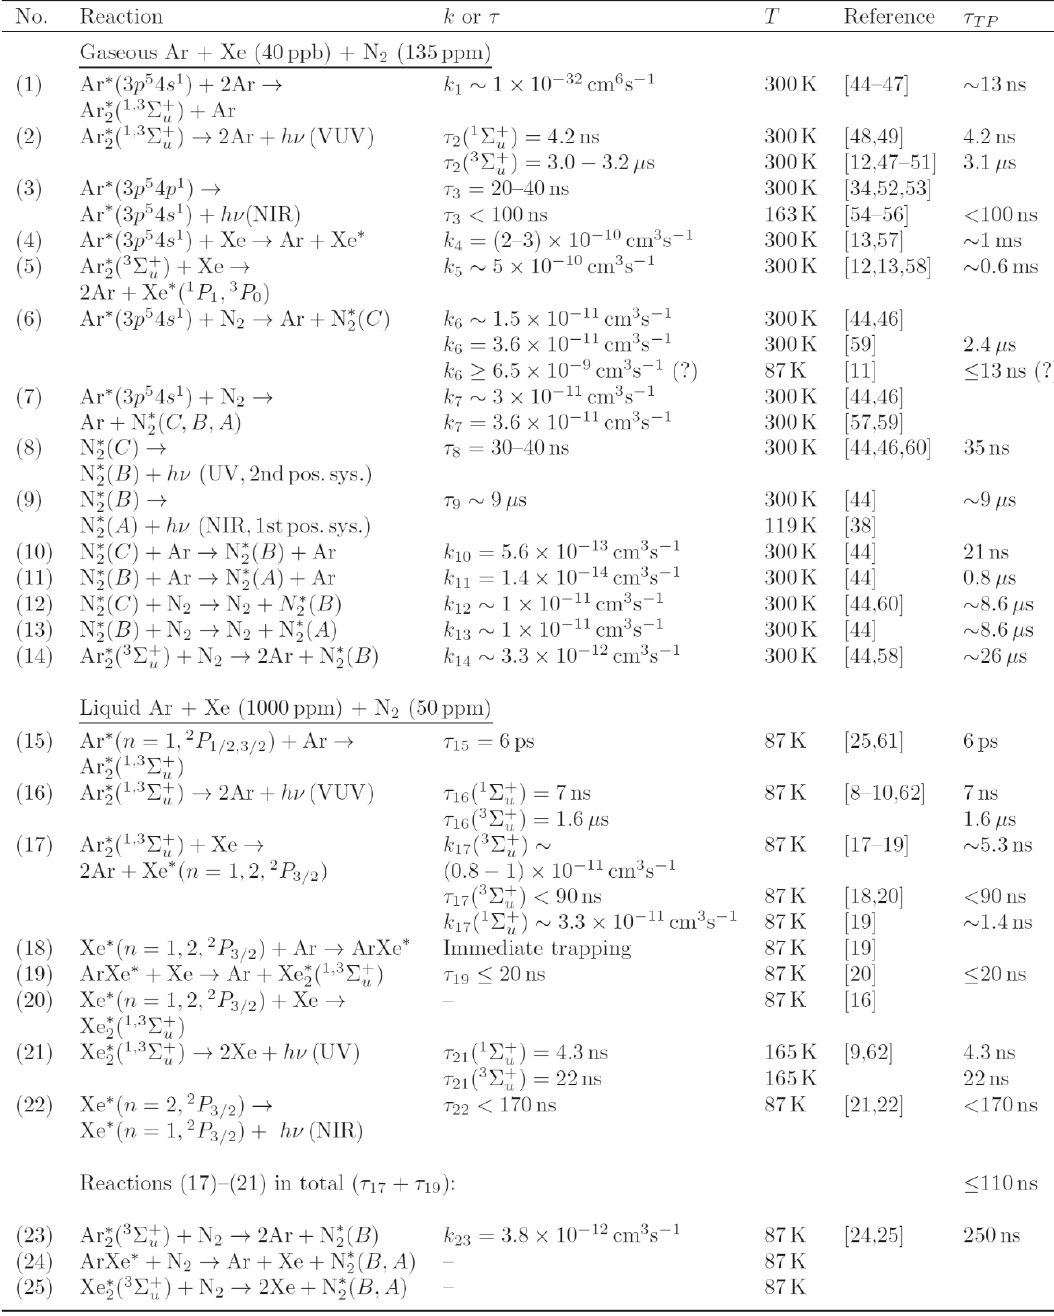
Table 1. Basic reactions of excited species relevant to the performance in the two-phase mode, namely in Ar in the gas and liquid phase, doped with Xe (1000 ppm in the liquid and 40 ppb in the gas phase) and N 2 (50 ppm in the liquid and 135 ppm in the gas phase), their rate (k) or time ( τ ) constants reported in the literature and their time constants reduced to given atomic densities at 87 K ( τ TP ), in particular for Ar to that of 8.63 × 10 19 cm − 3 and 2.11 × 10 22 cm − 3 in the gas and liquid phase, respectively [7]. The references presented in the table are those of [7].